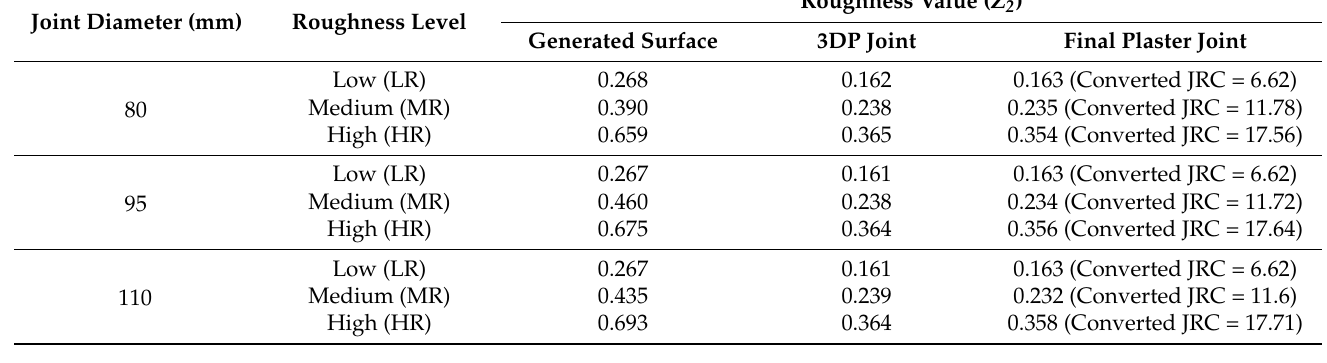
Figure 2. Preparation procedure of joint specimens; ( a ) 3DP mold, ( b ) silicone mold, ( c ) plaster rough joint, ( d ) encapsulated joint. Table 3. Roughness properties of generated, 3DP, and final plaster joint surfaces.